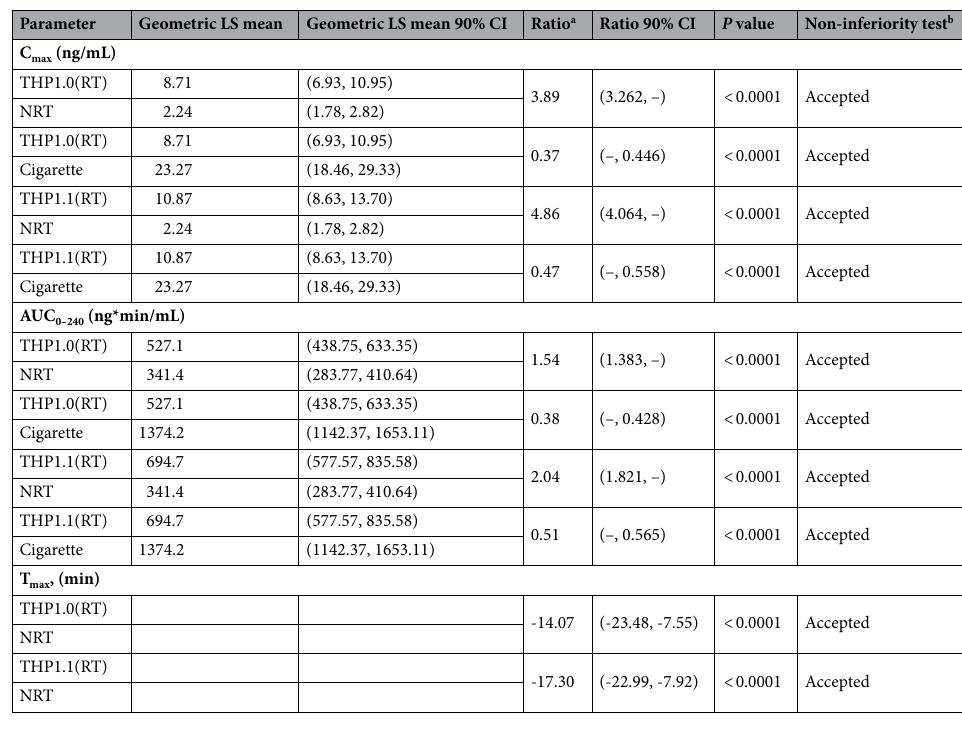
Table 3. Comparison of plasma nicotine pharmacokinetic parameters.